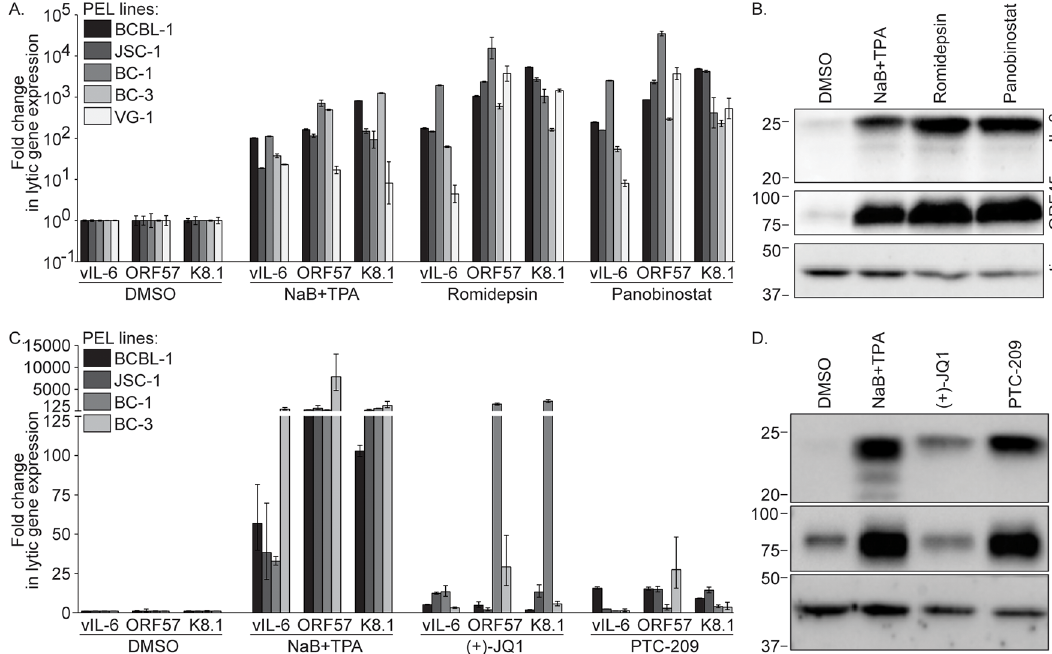
Fig 2. Romidepsin, Panobinostat, (+)-JQ1, and PTC-209 induce KSHV lytic gene expression. (A) RT-qPCR analysis for KSHV lytic transcript levels was performed on PEL cells treated with DMSO, NaB+TPA, or 1 μ M Romidepsin or Panobinostat for 48 hours. Lytic transcript levels were normalized to GAPDH, and the fold difference between DMSO and compound treated cells was calculated. (B) Immunoblot analysis for vIL-6, ORF45, or actin was performed on lysates from BCBL-1 cells treated as in (A). Approximate molecular mass (kDa) marker positions are indicated to the left of each blot. (C) RT-qPCR analysis for KSHV lytic transcript levels was performed as in (A) on PEL cells treated with DMSO, NaB+TPA, or 10 μ M (+)-JQ1 or PTC-209 for 120 hours. (D) Immunoblot analysis was performed on lysates from BCBL-1 cells treated as in (C). Data are representative of at least two independent experiments performed in triplicate; mean and standard error are shown.